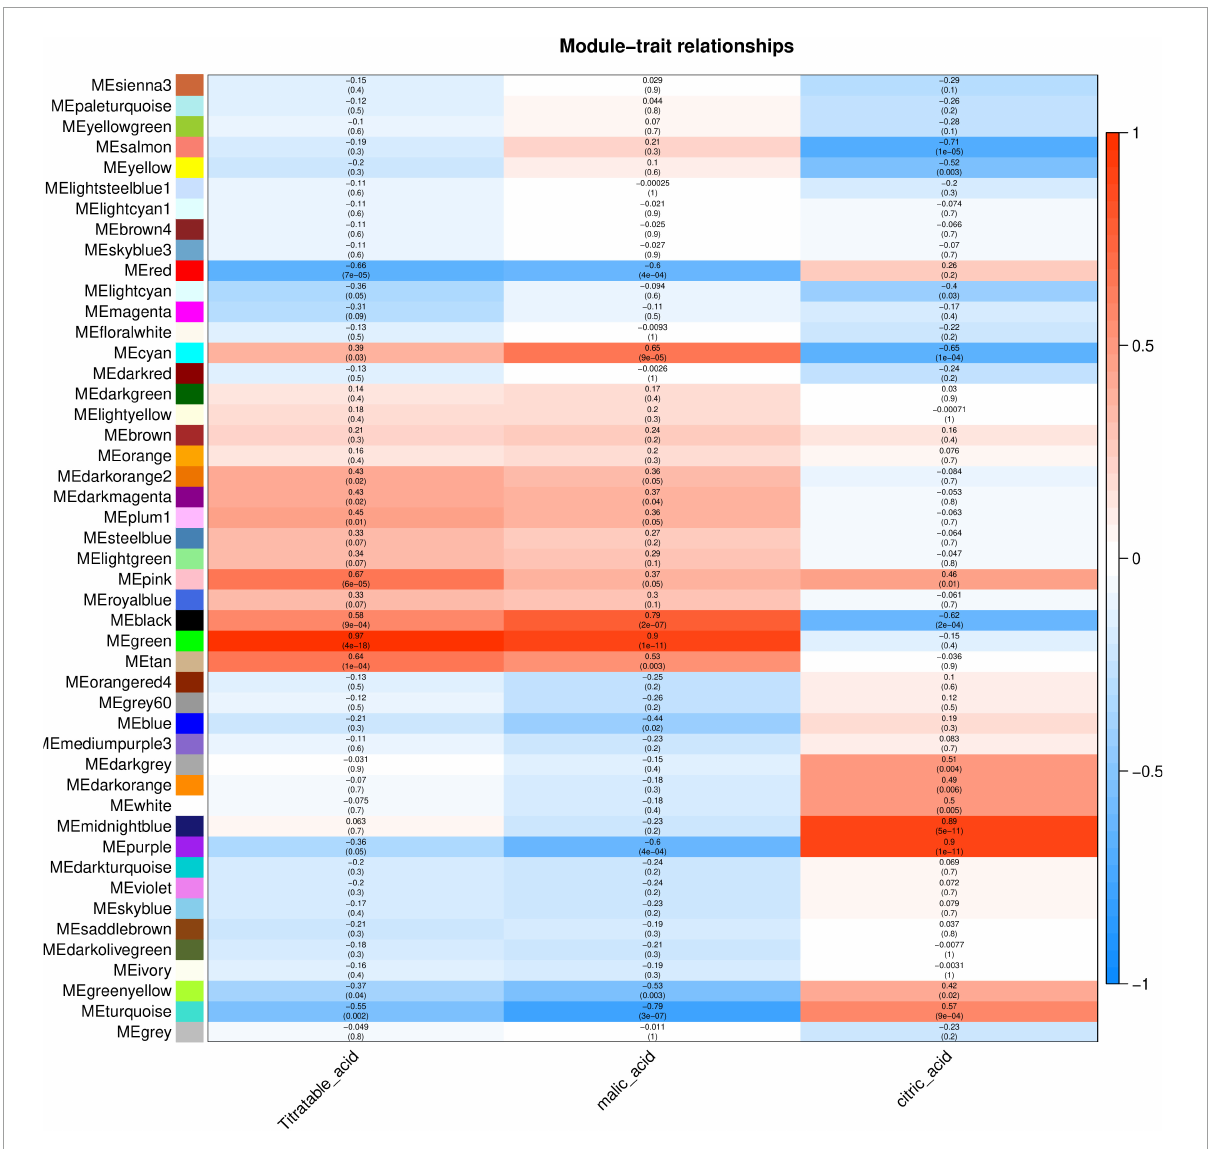
FIGURE5 Correlation between organic acid content and modules of Chinese dwarf cherry fruit. The colors from blue to red represent r 2 values from –1 to